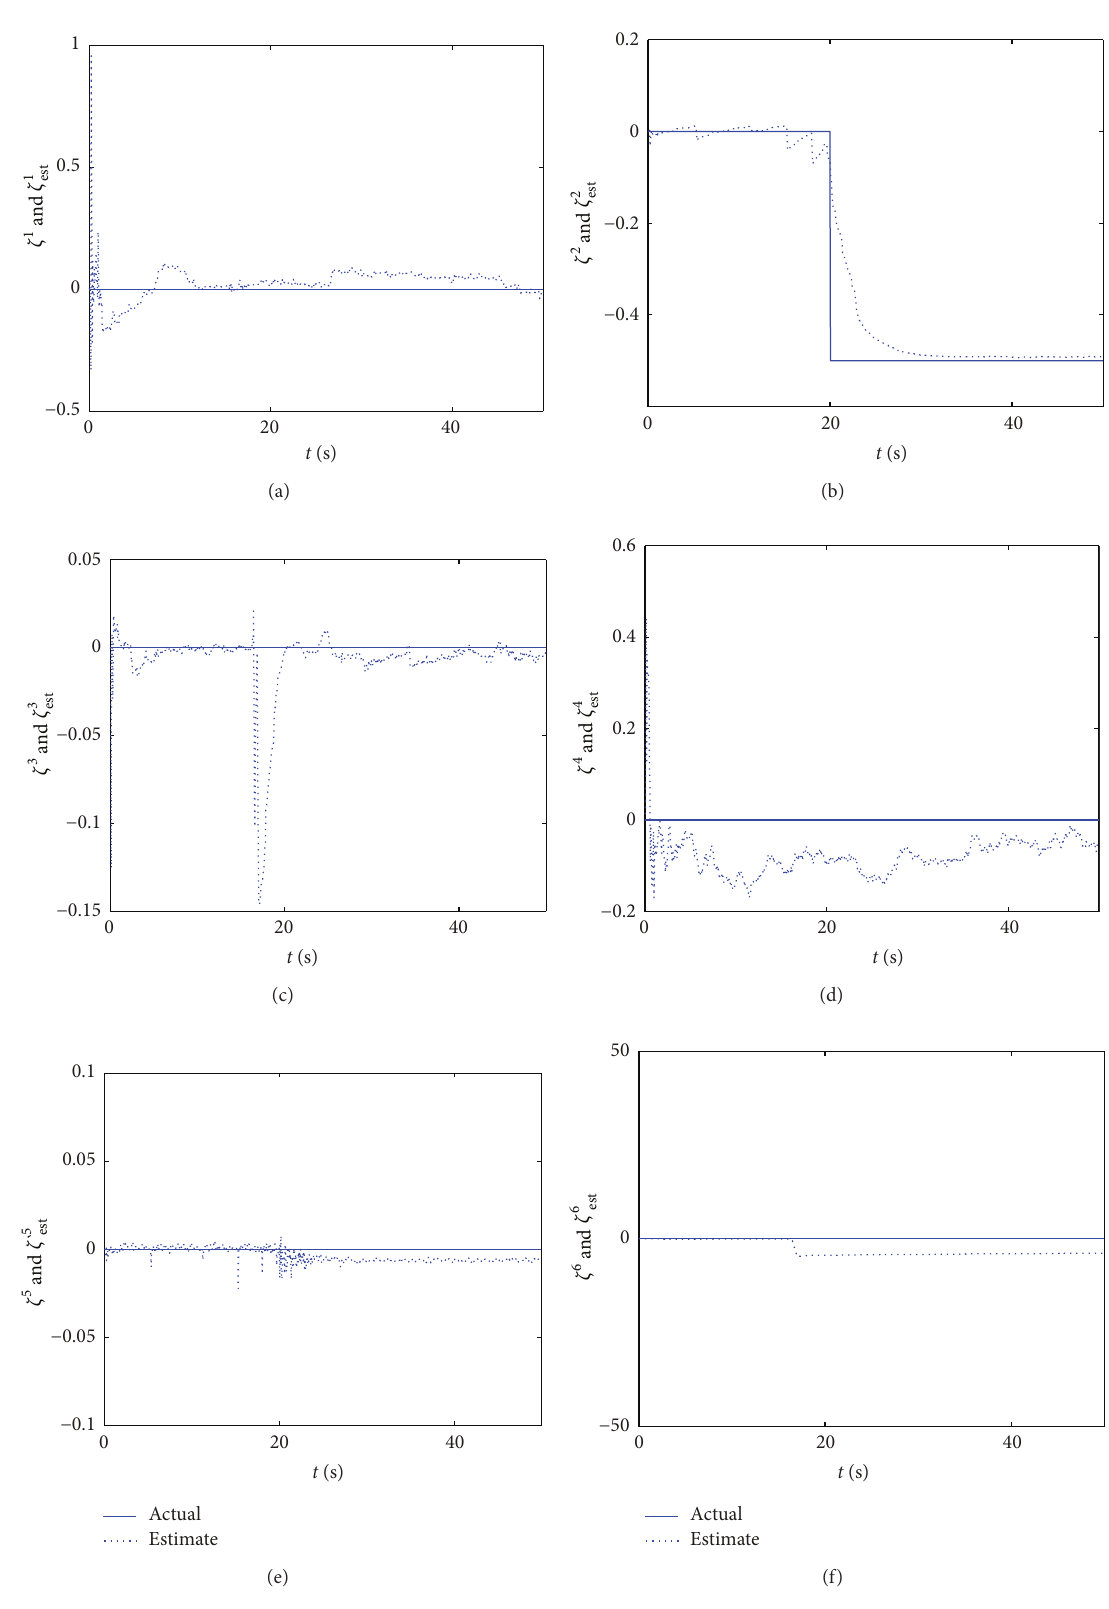
Figure 6: Actual inputs and estimations when 50% partial loss in stabilizer occurred at 20